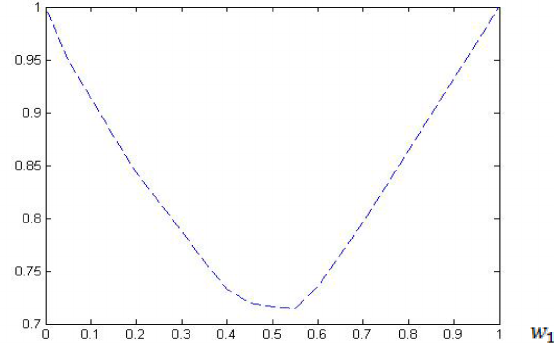
Fig. 10. Trend of Z considering w 1 and w